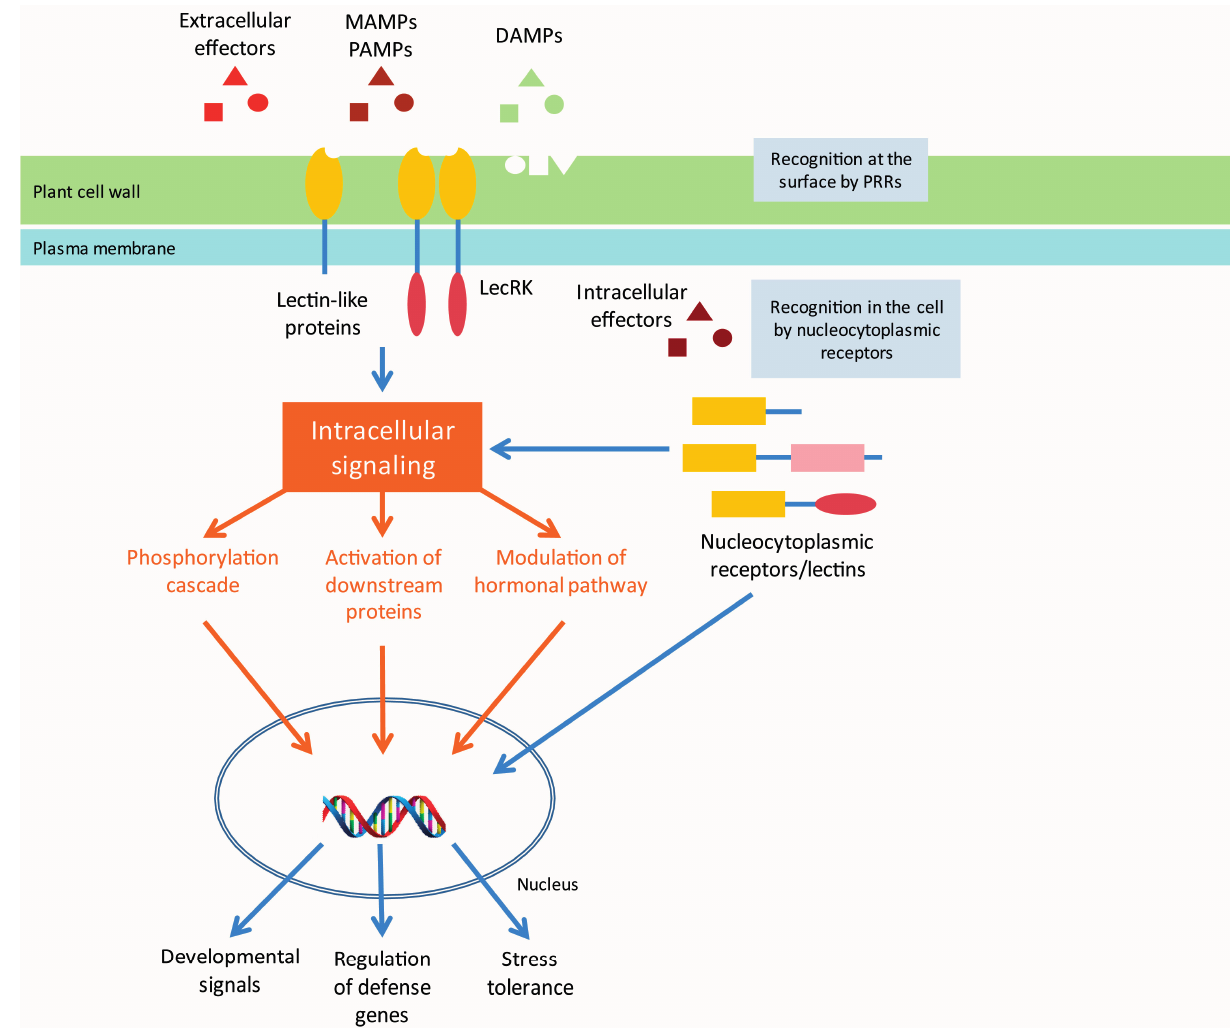
Figure 2. Model of plant innate immunity by lectin PRRs. After perceiving extracellular signals (pathogen/microbe-associated molecular patterns (P/MAMPs), damage associated molecular patterns (DAMPs) or pathogen-derived effector proteins) by membrane bound pattern recognition receptors (PRRs) with lectin domains (lectin receptor kinases LecRKs and lectin-like proteins), an intracellular signaling cascade is initiated in plants. This signaling cascade can include downstream protein phosphorylation, transcription factor activation, or modulation of hormonal pathways, ultimately leading to activation of stress-responsive or developmental signal-responsive genes and pathogen/microbe triggered immunity (P/MTI). In addition, perception of intracellular effectors by nucleocytoplasmic receptors (potentially including nucleocytoplasmic lectins), leads to activation of the effector triggered immunity (ETI). However, the precise signaling pathways leading to P/MTI and ETI are not fully known and need to be elucidated. Figure redrafted from [40,42]. In contrast to animal systems, where the C-type lectins represent a major player in the recognition of pathogens and the induction of the immune response, C-type lectins in plants are rather rare. Only one C-type LecRK has been identified in Arabidopsis and rice, and its function is not fully elucidated